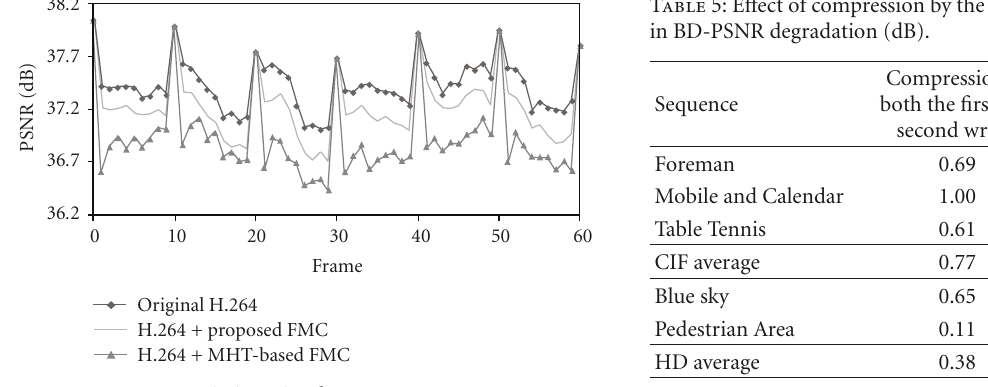
Figure 14: PSNR variations in the Foreman sequence over 60 frames.